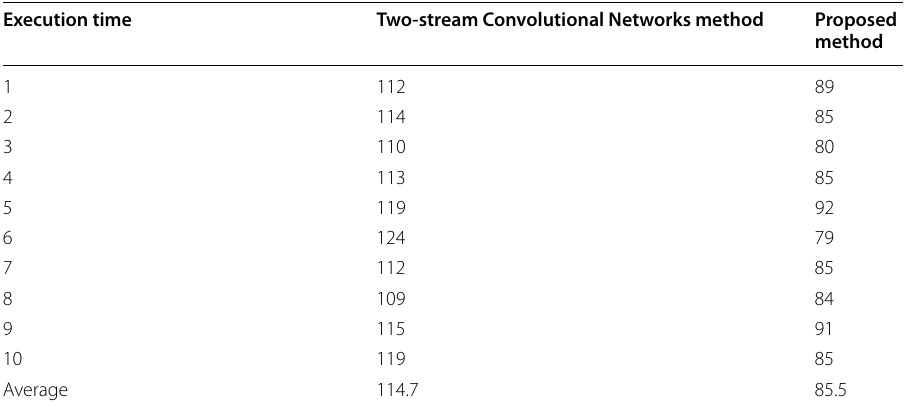
Table 4 Comparison of expectation time in proposed method and Two-stream Convolutional Networks